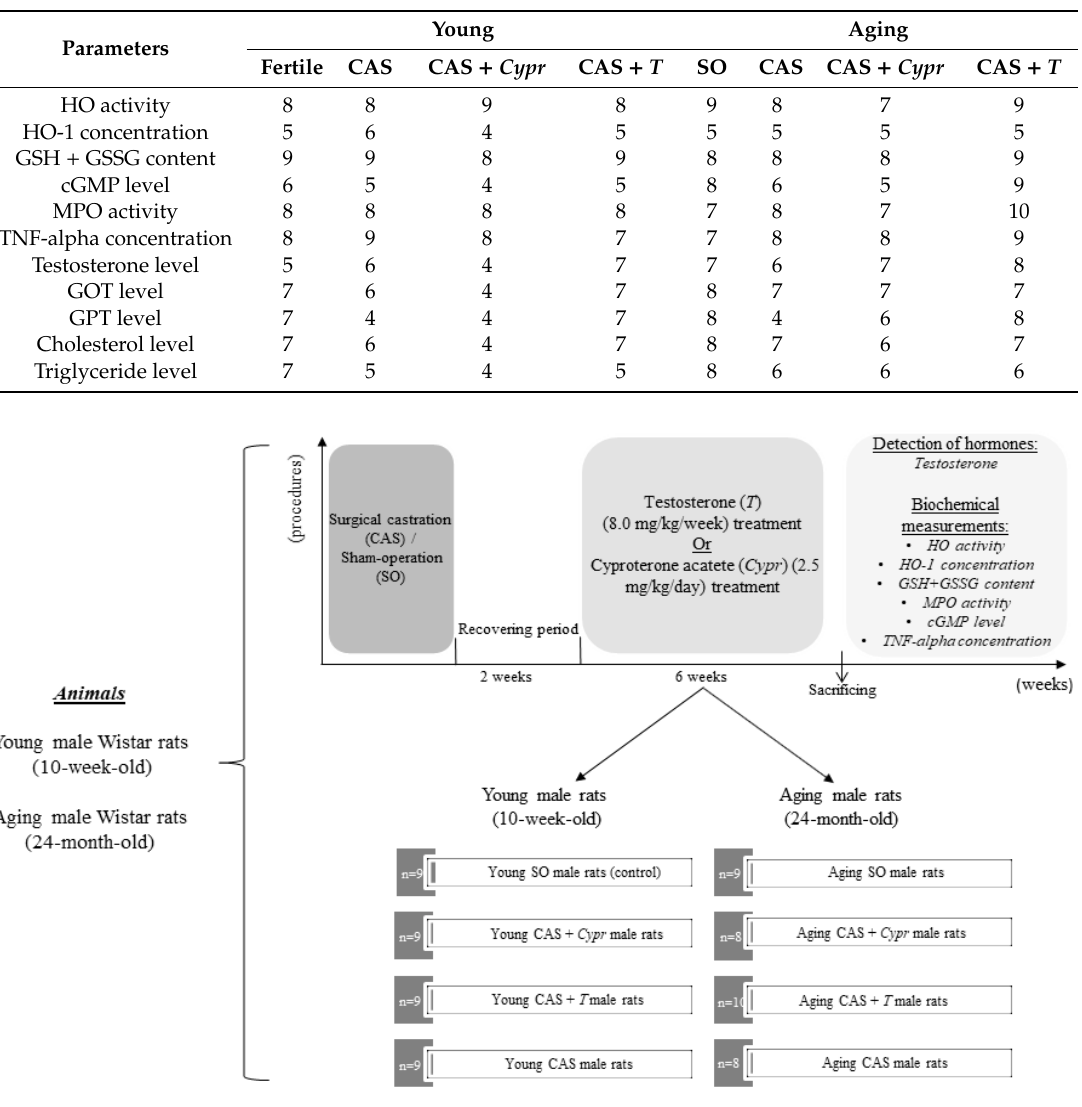
Figure 1. The experimental protocol of the study. CAS = surgical castration, SO = sham operation, T = testosterone replacement therapy, Cypr = cyproterone acetate treatment, HO = heme oxygenase enzyme, HO-1 = heme oxygenase-1, GSH + GSSG = reduced glutathione / oxidized glutathione, MPO = myeloperoxidase enzyme, and cGMP = cyclic guanosine monophosphate.